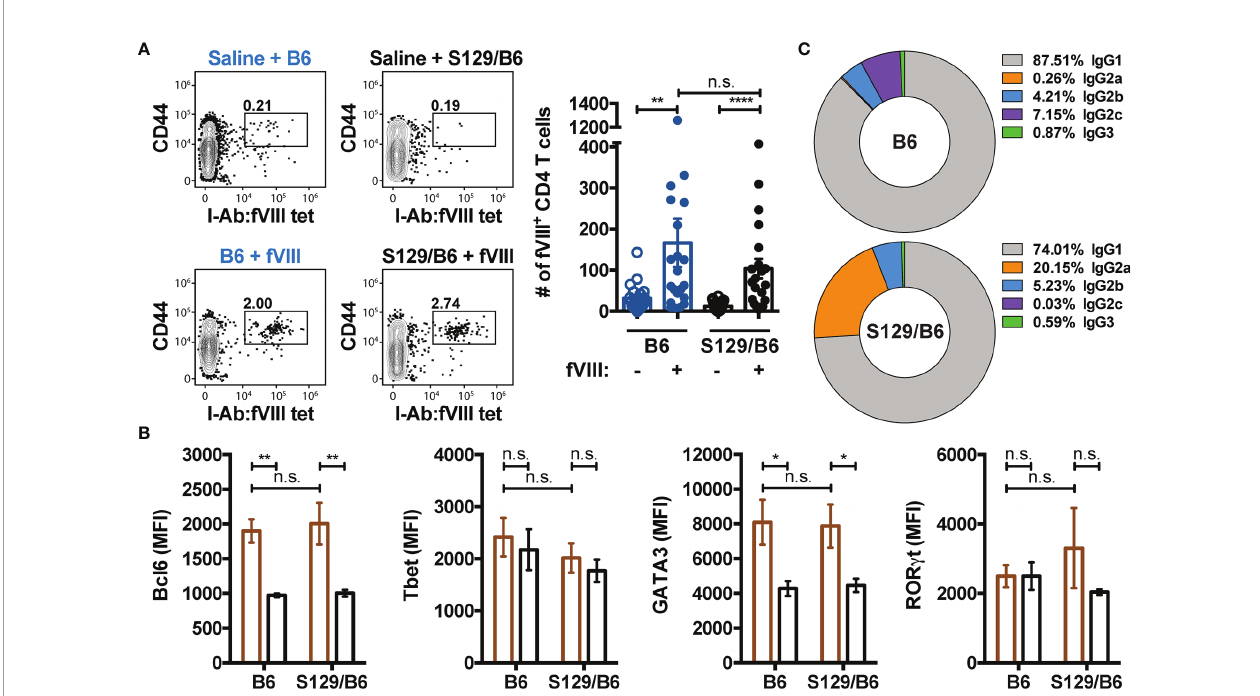
FIGURE 4 | B6 and S129/B6 FVIII de fi cient mice develop a comparable CD4 T cell response to FVIII. (A) Gating strategy and graphical demonstration of the absolute counts of FVIII reactive CD4 T cells in B6 and S129/B6 FVIII de fi cient mice administered saline or 4 weekly infusions of 1 m g FVIII, followed by a 2 m g challenge. Splenocytes were collected 7 days post challenge, and antigen experienced FVIII speci fi c CD4 T cells were enriched as well as quanti fi ed using the FVIII MHC Class II tetramer (I-A b : FVIII 2210-2229 ). (B) FVIII speci fi c CD4 T cells enriched using the FVIII MHC Class II tetramer were intracellular stained for transcription factors Bcl6, Tbet, GATA3 and ROR g t to assess the differentiation of the CD4 T cell response to FVIII. Mean fl uorescent intensity (MFI) values of the indicated transcription factors in FVIII MHC Class II tetramer positive (brown) versus FVIII MHC Class II tetramer negative (black) CD4 T cells were used to evaluate the polarization of the CD4 T cell response. (C) Percentage of IgG subclasses (IgG1, IgG2a, IgG2b, IgG2c, and IgG3) in the total IgG response of B6 and S129/B6 FVIII de fi cient mice administered 4 weekly infusions of 1 m g FVIII, followed by a 2 m g challenge. Plasma was collected one-week post challenge and IgG subclasses were measured by ELISA. Error bars represent ± SEM. Statistics were generated using a Kruskal-Wallis with a Dunn ’ s multiple comparison post-test. There were 18-20 mice per group in panels (A, C) , and 10-11 mice per group in panel (B) . The results shown are the combined results from 2-4 experiments. *p < 0.05, **p < 0.01, ****p < 0.0001, and n.s. indicates not signi fi